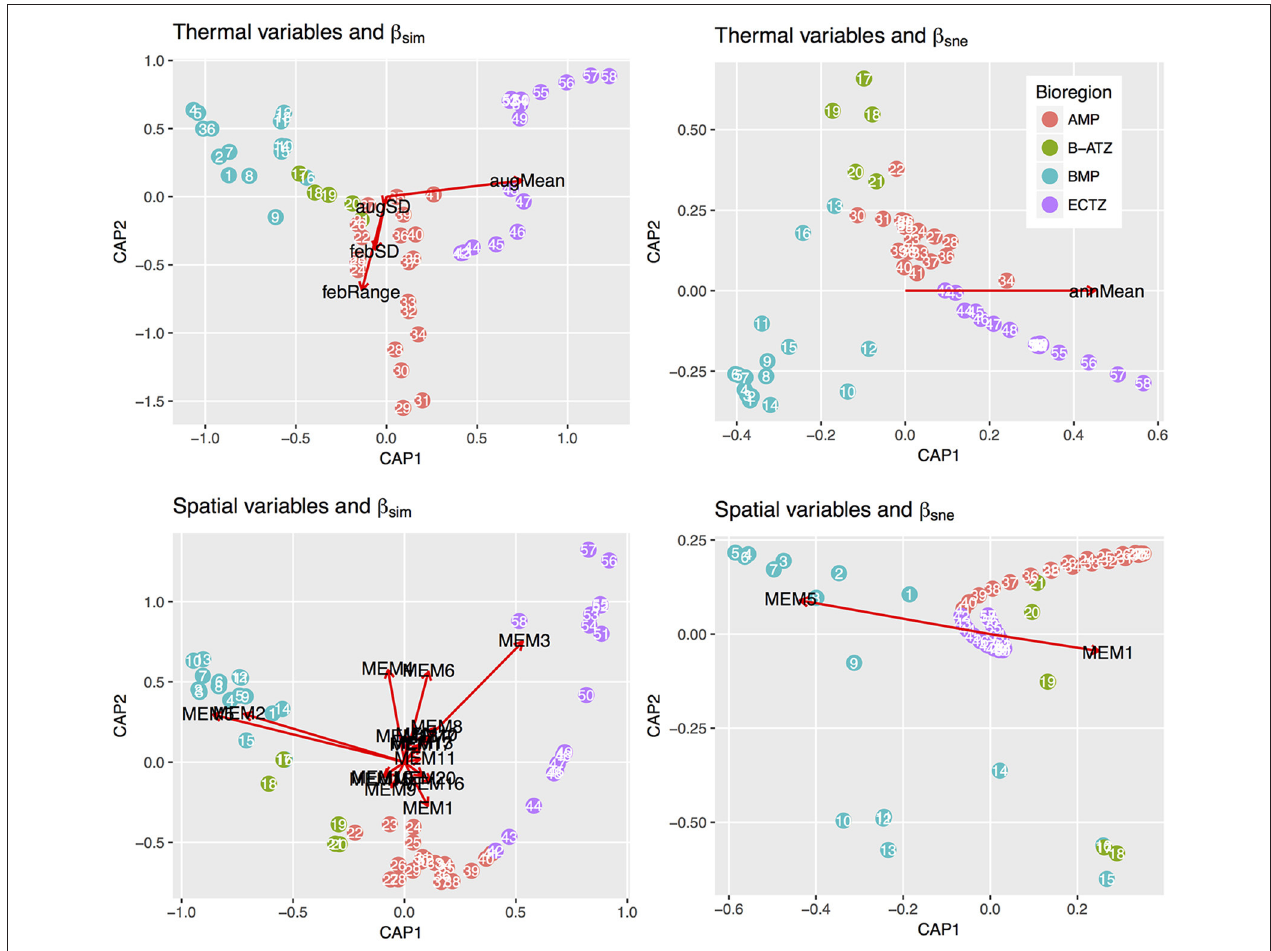
FIGURE 2 | db-RDA biplots of lc scores for β sim and β sne constrained by the thermal and spatial MEM variables. The only two canonical axes shown are CAP1 and CAP2 since these capture the bulk of the inertia present in the ordinations. The constraining vectors were selected during the db-RDA steps.